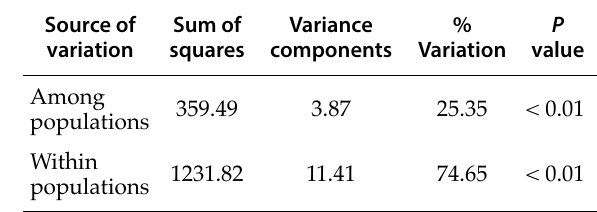
Table 2. Genetic diversity parameters of four sunflower broomrape populations (ORGD, ORG, ORH, and ORK) from Tunisia.